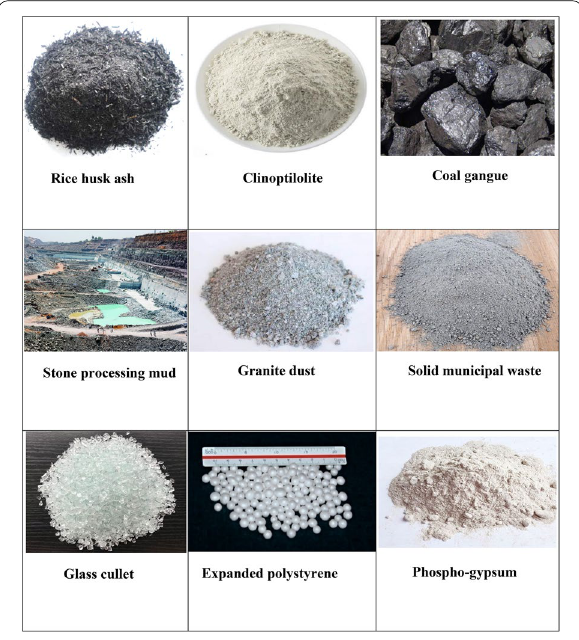
Fig. 2 Different wastes used for AAC formation (Source: Google